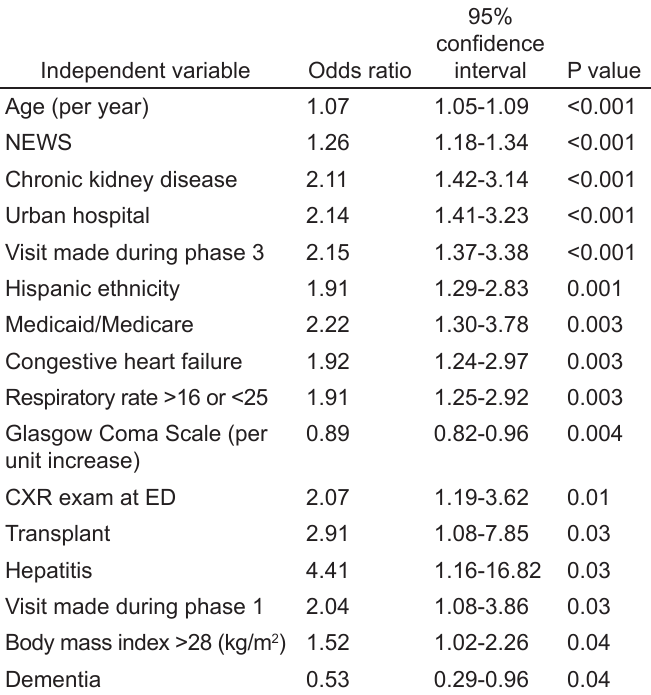
Table 2. Multivariable logistic regression model with death as the dependent